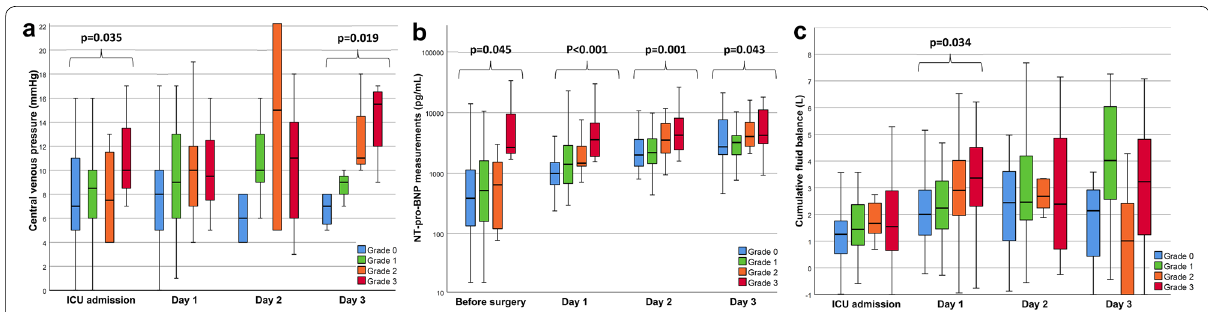
Fig. 4 Clinical parameters in relationship with the Venous Excess UltraSound (VExUS) grading system C during the peri‑operative period. a Central venous pressure at the time of ultrasound assessment in relationship with VExUS C grading system. b N‑terminal pro‑beta natriuretic peptide (NT‑pro‑BNP) in relationship with VExUS C grading system. c Cumulative fluid balance in relationship with VExUS C grading system. Significant results ( p < 0.05) are highlighted. Complete results of comparisons are presented in Additional file 1: Table S3